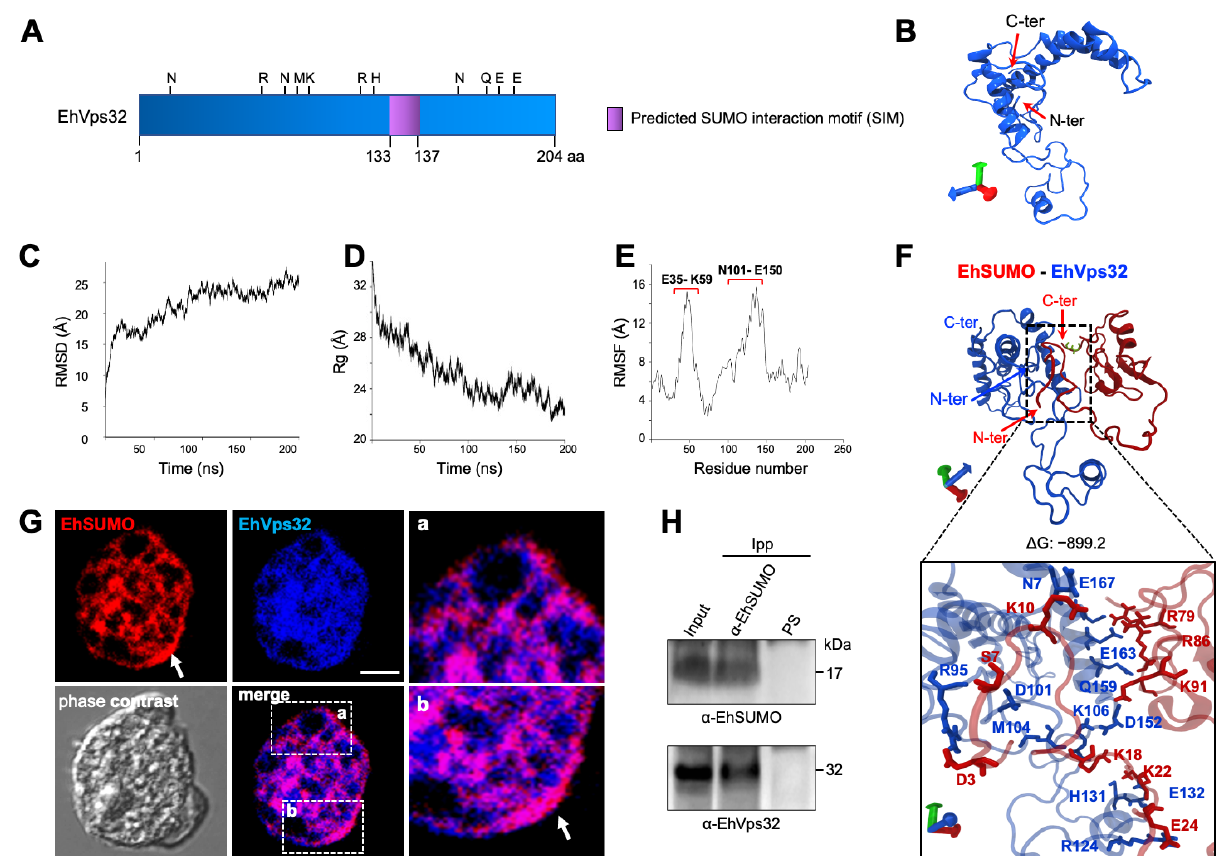
Figure 8. Association of EhSUMO and EhVps32. ( A ) Schematic representation of SIM (purple) site in EhVps32 protein. ( B ) Predicted model of EhVps32 after 200 ns of MDS. The N- and C-terminus regions are indicated. Structural analysis of MDS carried out by ( C ) RMSD, ( D ) radius of gyration, and ( E ) RMSF. Red brackets indicate the most flexible regions. ( F ) Molecular docking of EhSUMO (red) and EhVps32 (blue). Square: magnification of the interacting residues. Sticks in green indicate the glycines in EhSUMO. Axes: x, red; y, green; z, blue. ( G ) Immunofluorescence assays of trophozoites under basal conditions using α -EhSUMO (red) and α -EhVps32 (blue) antibodies. Squares: magnification of proteins colocalization (a, b, and arrow). Arrow: area of colocalization in the internal plasma membrane. Scale bar = 10 µ m. ( H ) Trophozoites in basal conditions were lysed and immunoprecipitated using α -EhSUMO antibody or pre-immune serum (PS) and immunoprecipitated proteins were analyzed by western blot using α -EhSUMO or α -EhVps32 antibodies. Numbers at right: molecular weight of immunodetected proteins in western blot